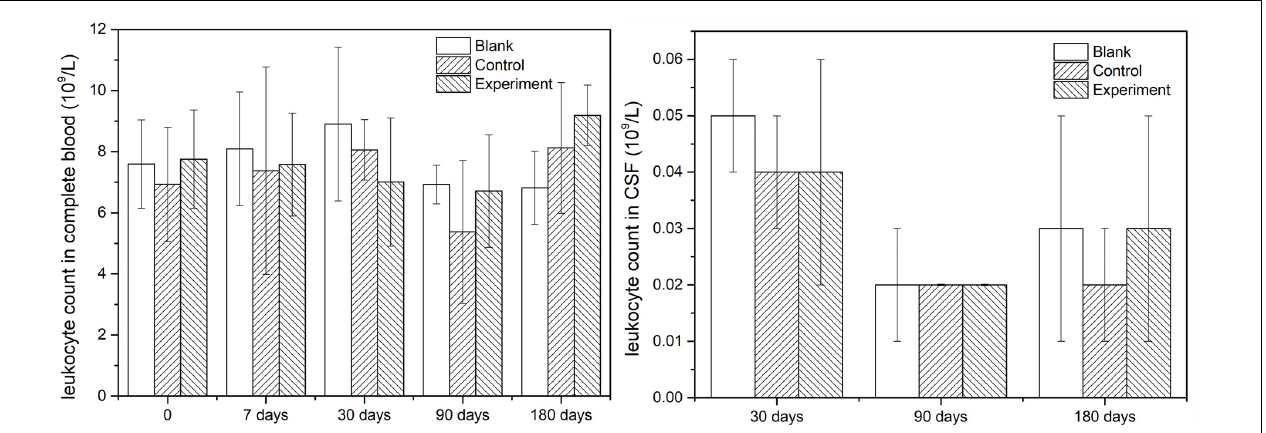
FIGURE 4 | The leukocyte counts in complete blood and